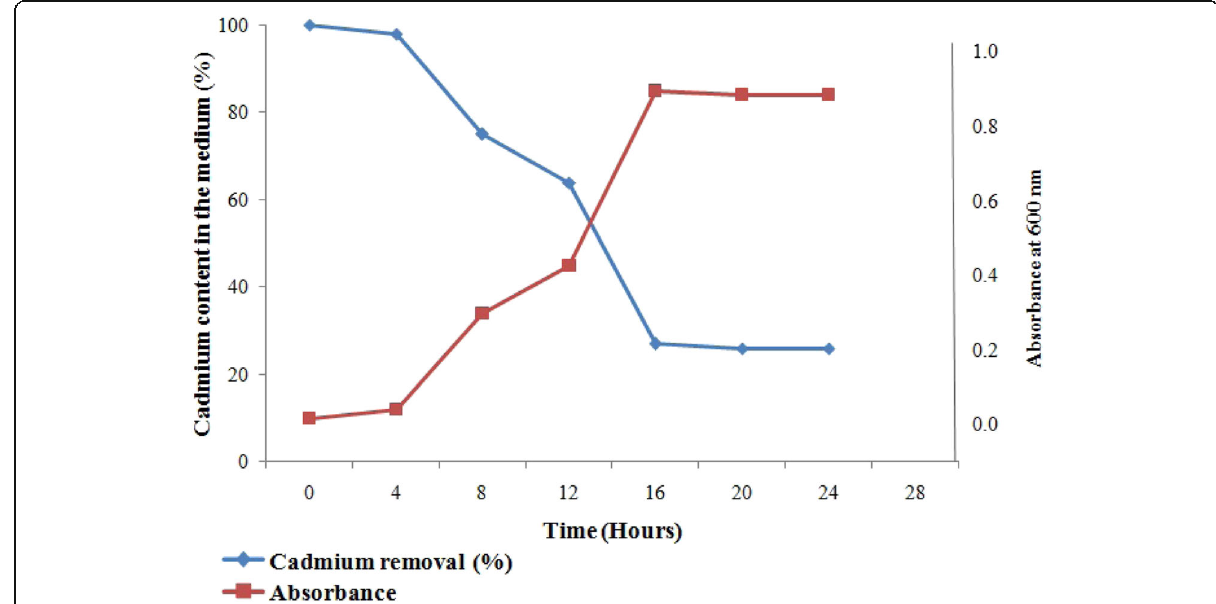
Fig. 6 Removal of cadmium by Bacillus subtilis (M3)